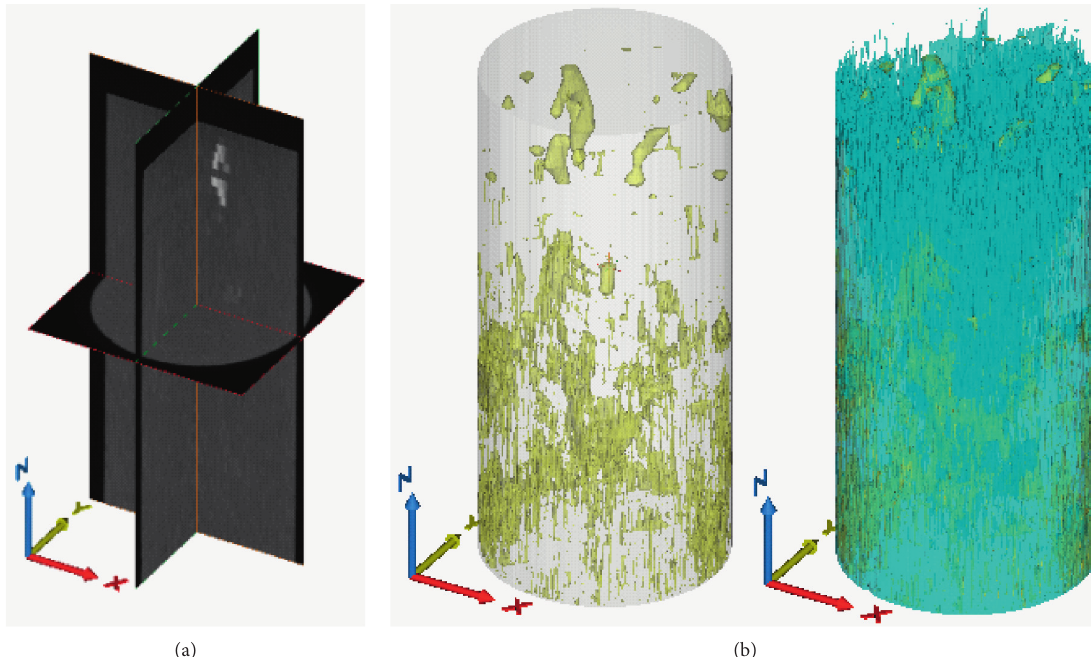
Figure 8: Reconstruction model of coal sample: (a) internal characteristic cross section of the sample and (b) component model of